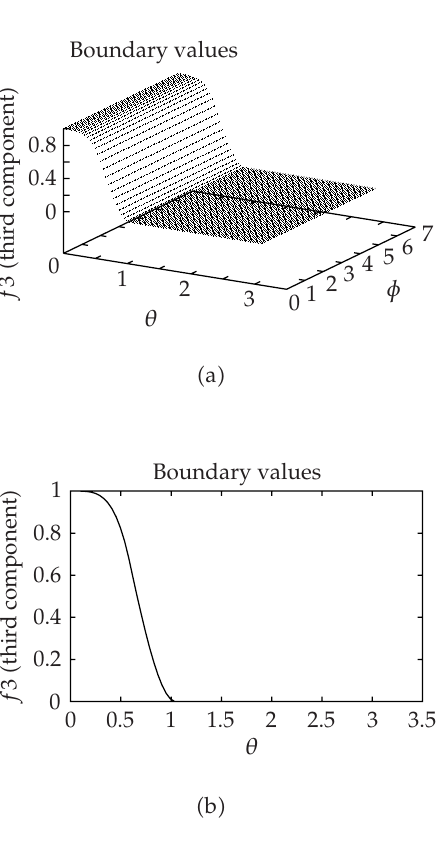
Figure 6.1 . Functional values of f ( third component ) : ( a ) on a longitude-latitude grid of points on Ω and ( b ) one-dimensional sec- tional